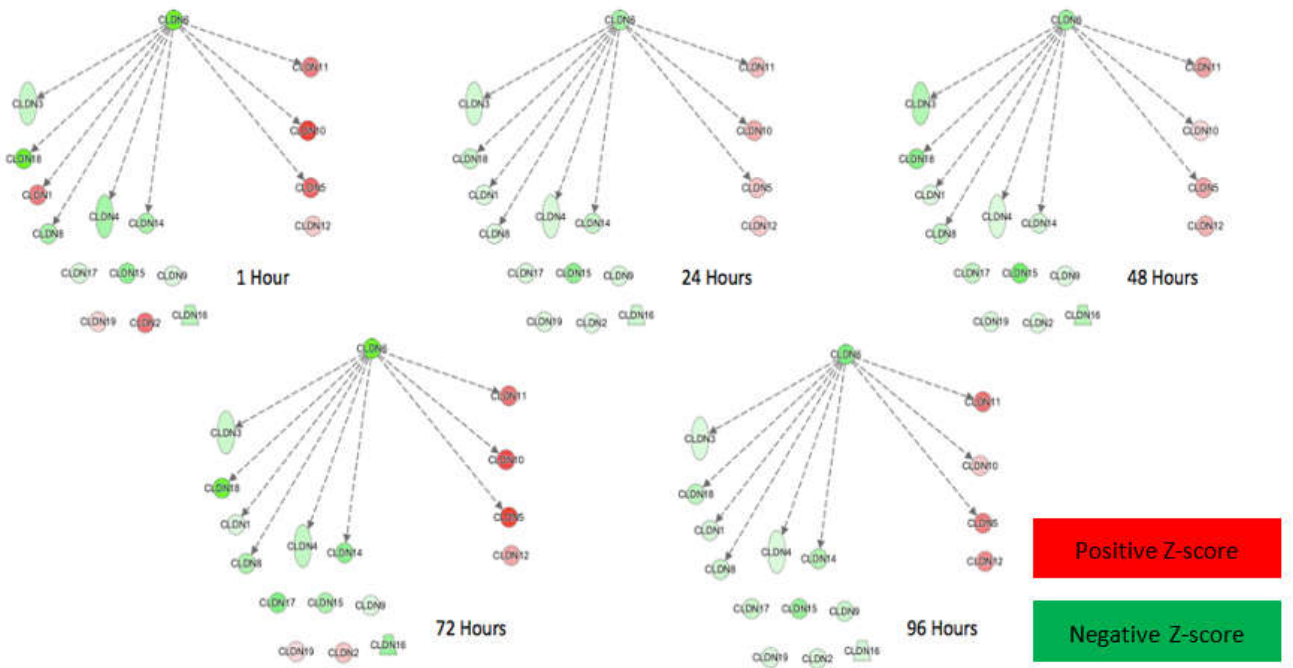
Figure 5. IPA revealed pathways associated with claudins as most impacted by H-FIRE treatment, with changes centered around claudin-6 ( Cldn6 ). Genes labeled in red were upregulated and those in green were downregulated relative to sham controls. The intensity of the indicated color corresponds with the z-score magnitude.